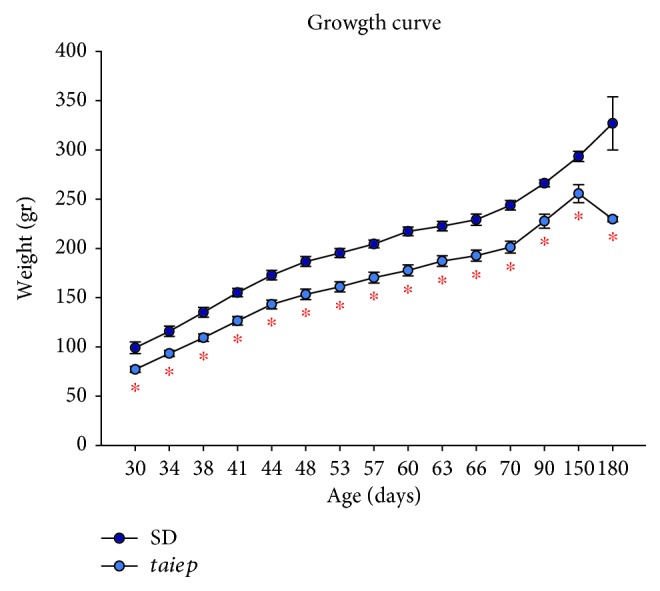
Plot of growth curve and weight (gr) with respect to age in days. Values are the mean and the error bars represent the standard error of measurements for 6 Sprague–Dawley rats (SD) or taiep rats in different ages of development. Comparisons were analyzed with an ANOVA followed by a Tukey's test, ∗p ≤ 0.001.